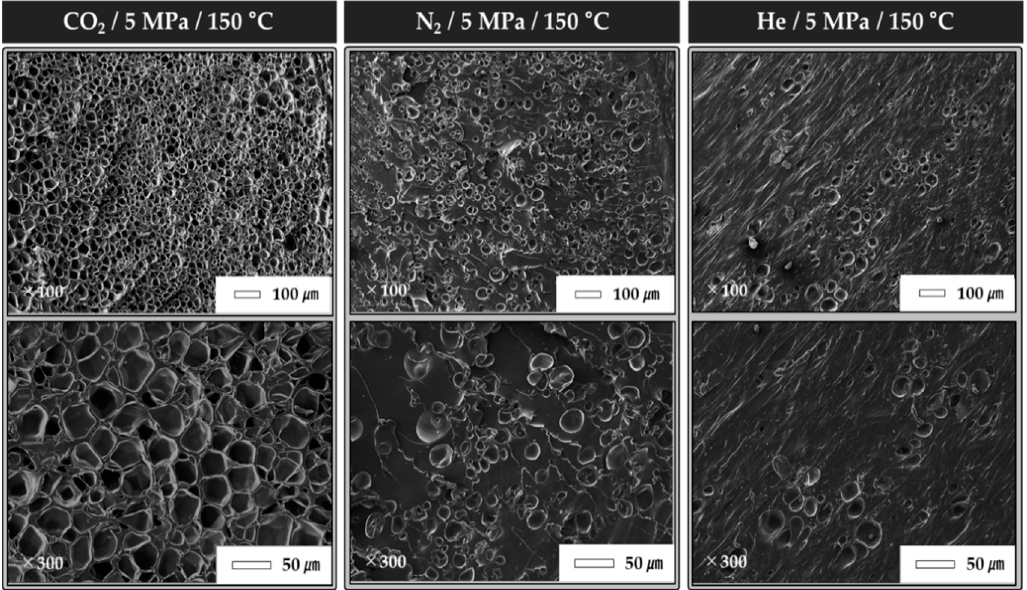
Figure 3. Experimental results for the correlation between the foaming ratio and the fixing ratio ( a ) and recovery ratio ( b ) according to the gas species. Table 6. Foaming properties of thermoplastic polyurethanes (TPU) according to gas species.